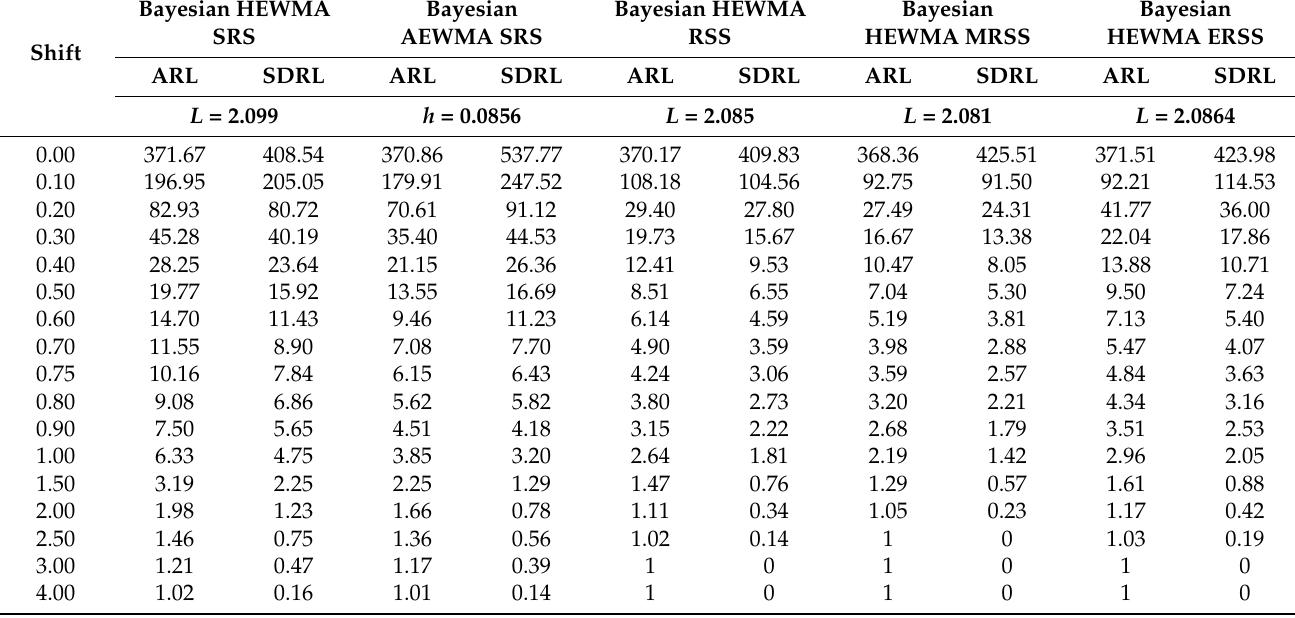
Table 1. The ARL and SDRL values of Bayesian HEWMA and Bayesian AEWMA control charts for posterior and posterior predictive distribution under SELF, for λ 1 = 0.10 and λ 2 = 0.05, n =